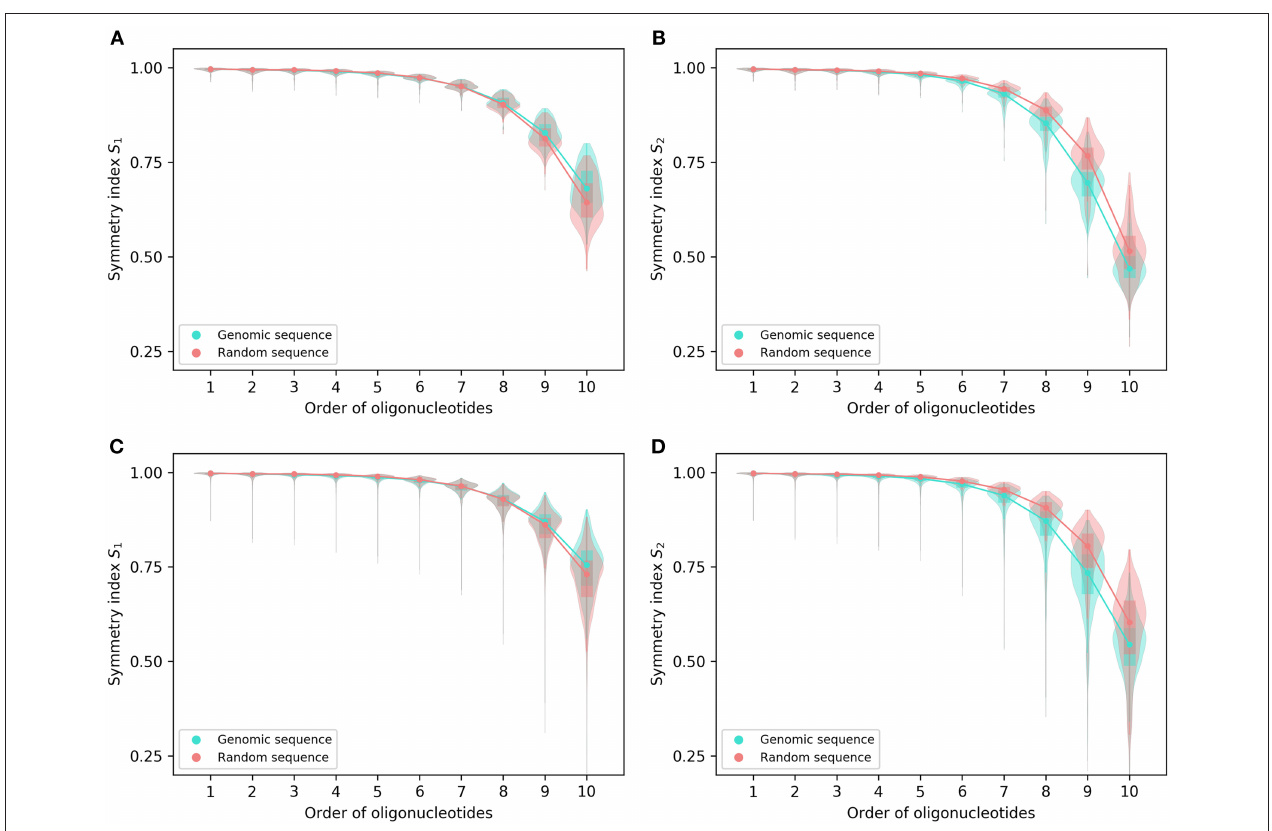
FIGURE 1 | Symmetry indexes of the complete genomes and their corresponding random sequences. (A) S 1 and (B) S 2 of 206 archaeal genomes and their corresponding random sequences. (C) S 1 and (D) S 2 of 2,659 bacterial genomes and their corresponding random sequences. The rectangles in the violin plot indicate the interquartile range of the data at different orders for genomic sequences and random sequences, respectively. Medians are marked with